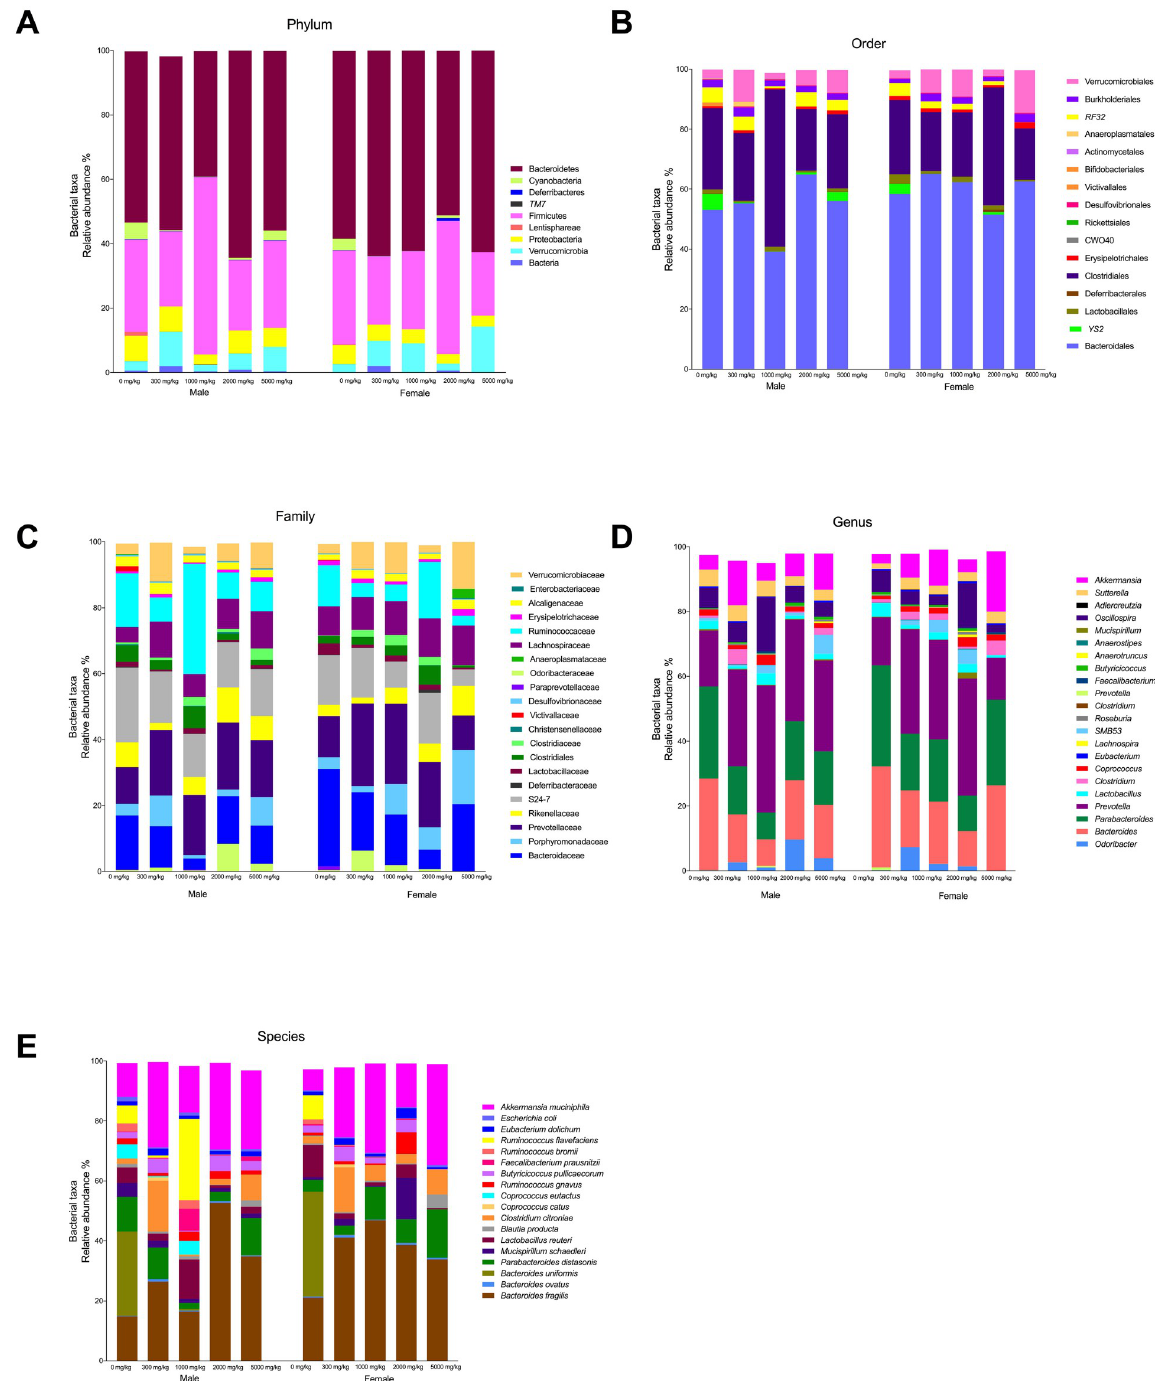
Fig 16. Effect of different doses of standardized Gl -2 extract of Ganoderma lucidum on the taxonomic distribution of bacterial communities from the gut microbiota of male (M) or female (F) Wistar rats after 14 experimental days. The main average bacterial relative abundance (BRA) is presented at the following taxonomic ranks: Phyllum (A), Order (B), Family (C), Genus (D), and Species (E). The dose administered per experimental group is described in the materials and methods section. Scientific names according to international database (http://www.catalogueoflife.org/).